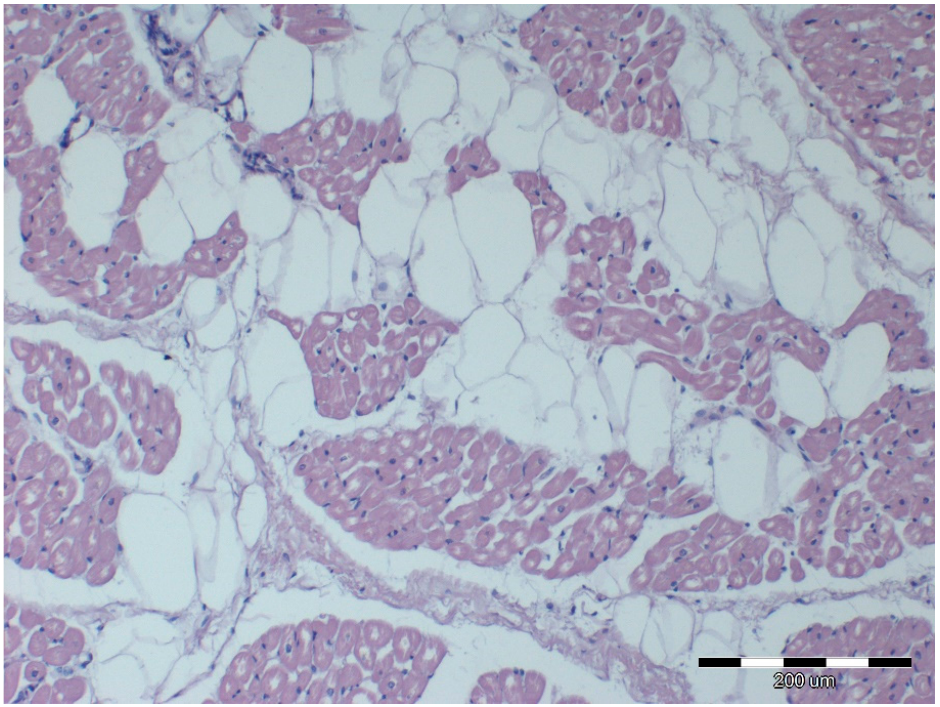
Figure 2. Microscopic image of the heart muscle specimen from an extremely obese horse. Left ventricular wall: myocardial cell degeneration; severe steatosis; HE staining; 100×.